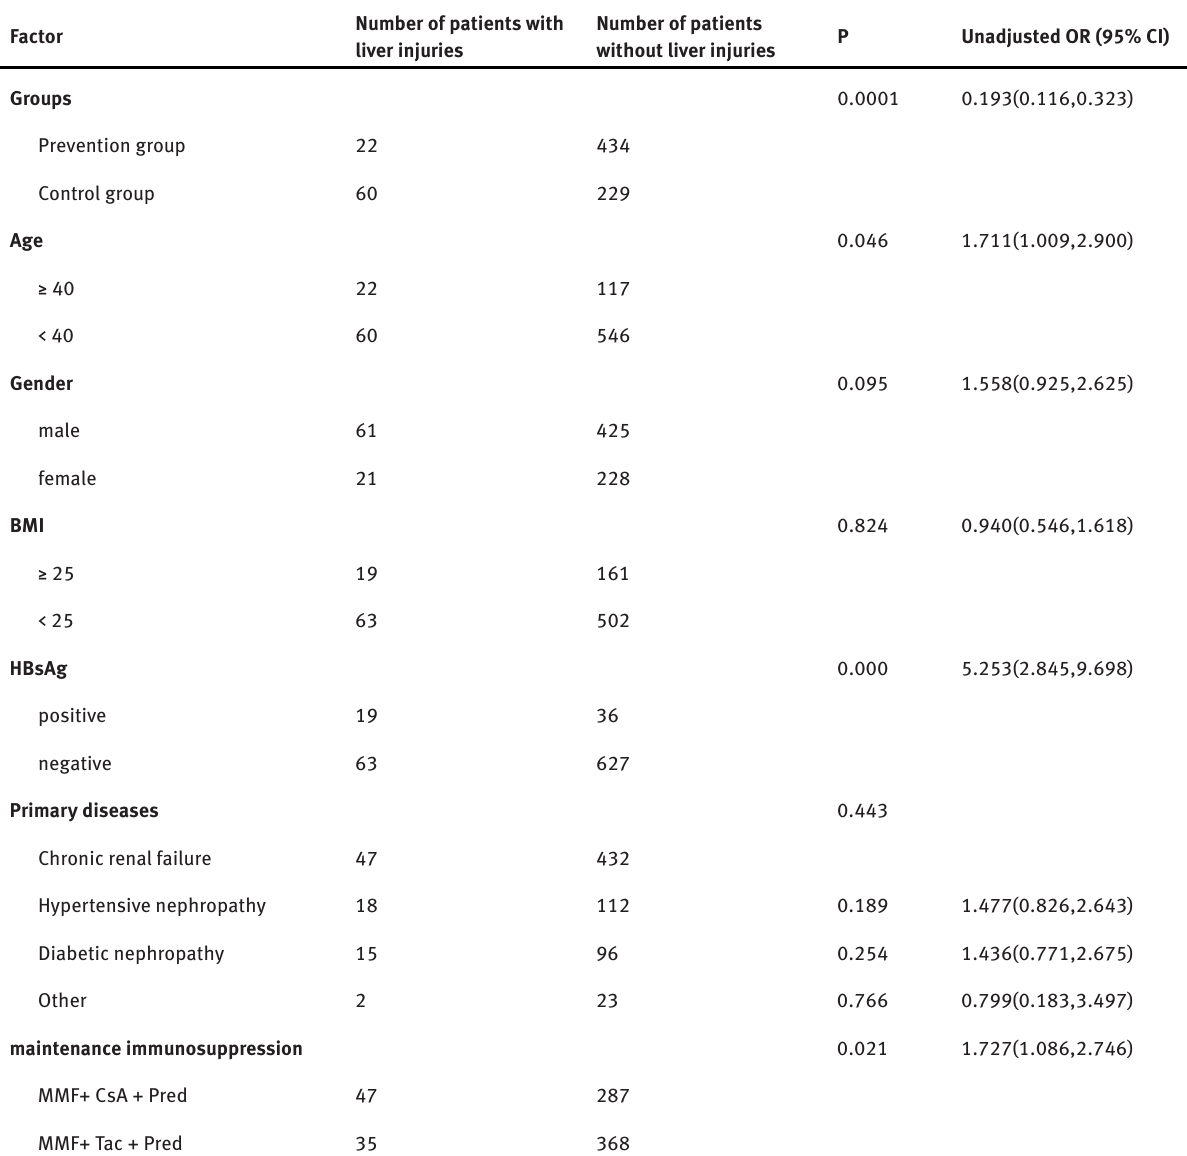
Table 2: Monofactorial analysis of the occurrence of liver injuries